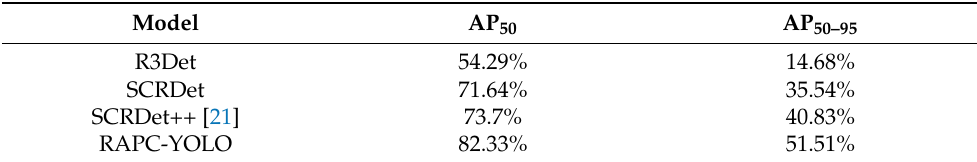
Figure 6. Comparison of detection results among our model and other detection models. Table 3. Performance comparison of different detection models.